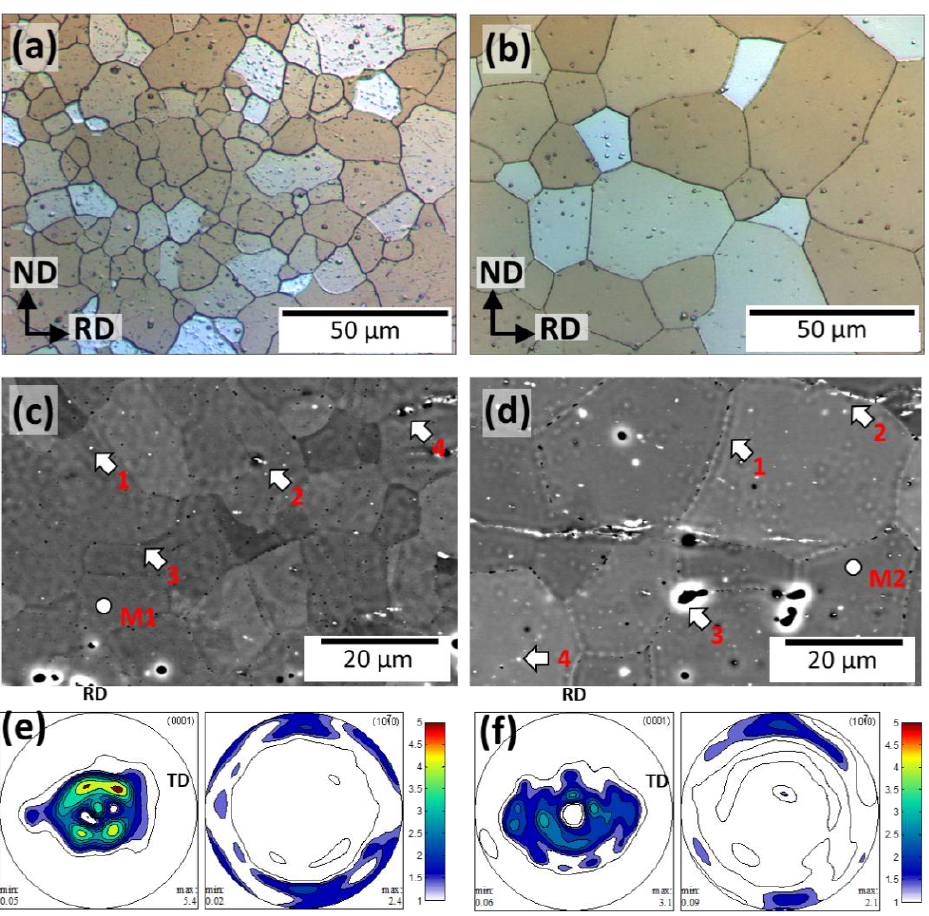
Figure 1. Optical microstructures, phase contrast QBSD-SEM microstructures and crystallographic textures in terms of the ⁡(0001) , {101̅0} pole figures for ZX-350: ( a ), ( c ) and ( e ), and ZX-450: ( b ), ( d ) and ( f ), respectively. Arrows and numbers indicate the zones where the composition was quantified. Table 1. Chemical composition of selected precipitates in Figure 1c,d was determined using EDS.